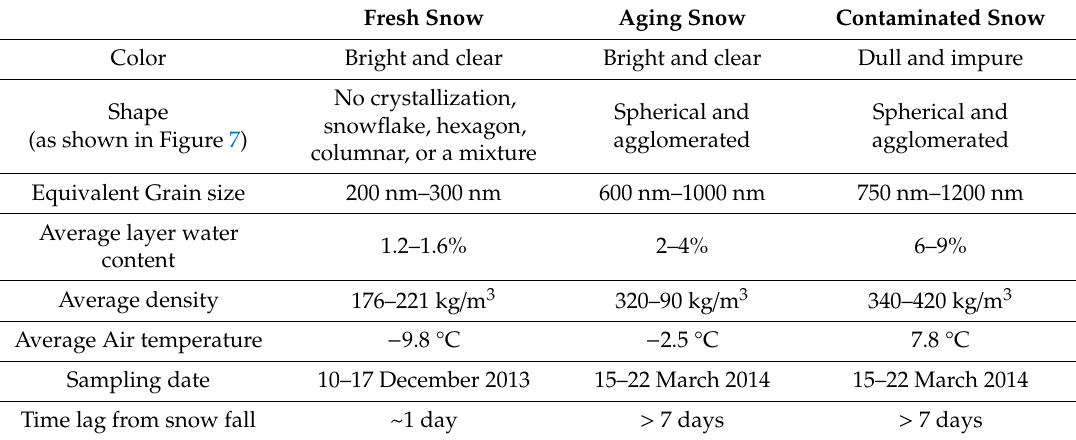
Figure 7. Magnified photographs of the new ( a ), uncontaminated aging ( b ), and contaminated aging ( c ) snow particles with measuring scale. Table 1. Comparison of properties of new, aging, and contaminated